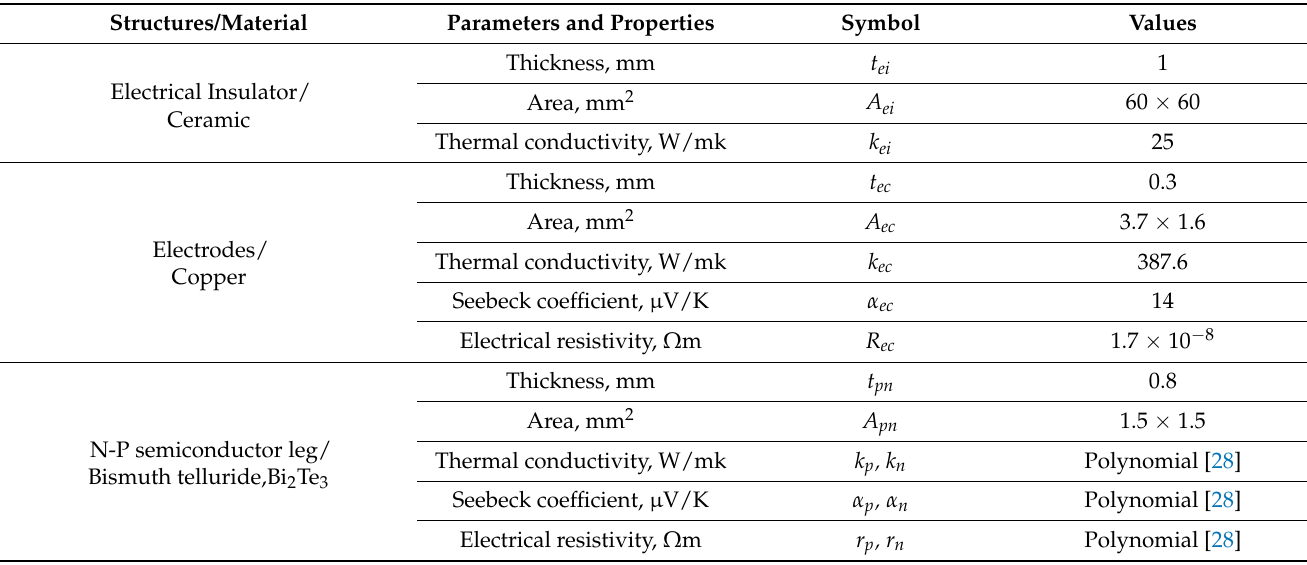
Figure 2. Schematic of WHR system for casting furnace. Table 1. Dimensions and thermo-electrical properties of components of TEG module.